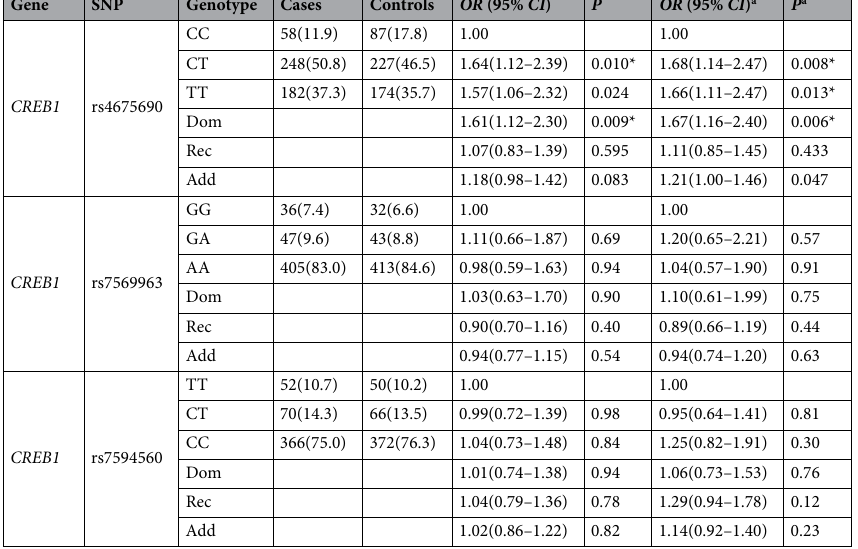
Table 3. Association between SNPs in CREB1 and aggression risk. Dom dominant model, Rec recessive model, Add additive model. a Adjusted by age, total maltreatment score. *Statistically